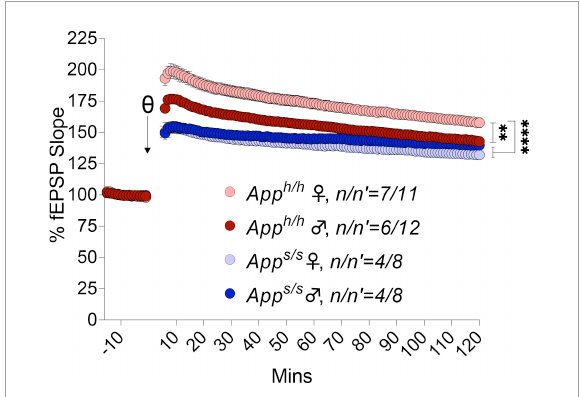
FIGURE10 LTP analysis in App h / h and App s / s rats. LTP recording in both genders of App s / s are weaker than controls. Additionally, in male App h / h is weaker compared to female App h / h (2-way ANOVA summary: female App h / h vs. female App s / s F ( 1 , 17 ) = 36.82, p < 0.0001****; female App h / h vs. male App s / s F ( 1 , 17 ) = 25.48, p < 0.0001****; female App h / h vs. male App h / h F ( 1 , 21 ) = 11.54, p = 0.0027**; female App s / s vs. male App s / s F ( 1 , 14 ) = 1.266, p = 0.2795; male App h / h vs. male App s / s F ( 1 , 18 ) = 5.355, p = 0.0327*; male App h / h vs. female App s / s F ( 1 , 18 ) = 12.02, p = 0.0028**). Each genotype/gender were compared separately. Data are represented as mean ± SEM. Data